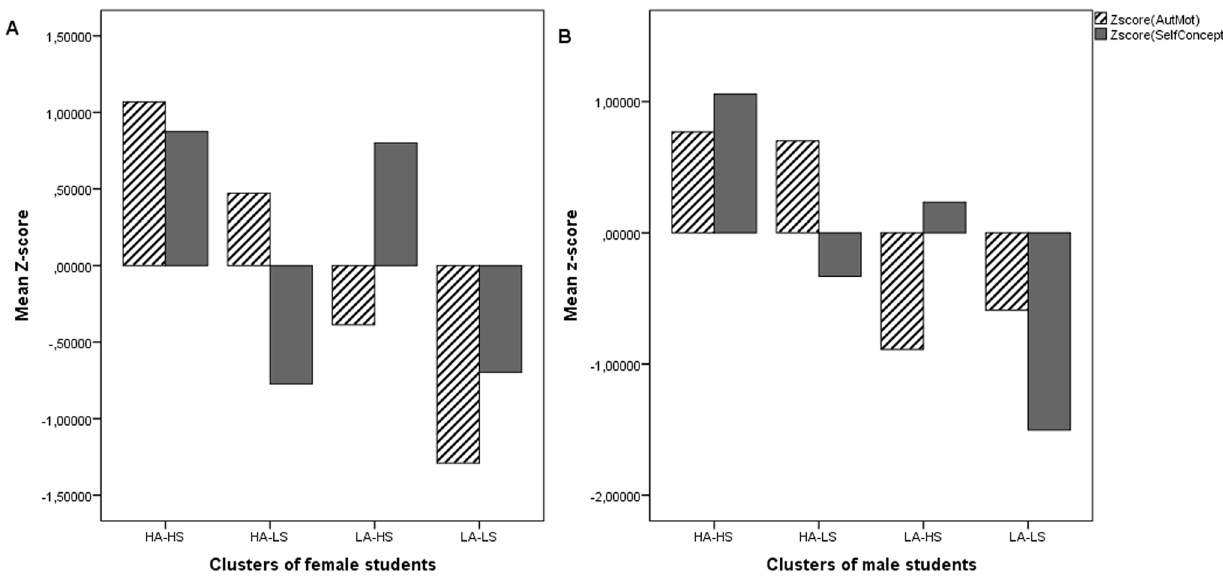
Figure 2. Autonomous motivation and academic self-concept of four-cluster solution of male and female STEM students separately. Average gender-specific z-scores for autonomous motivation (striped bar) and academic self-concept (gray bar) of the four-cluster solution of female (panel A) and male (panel B) STEM students separately.